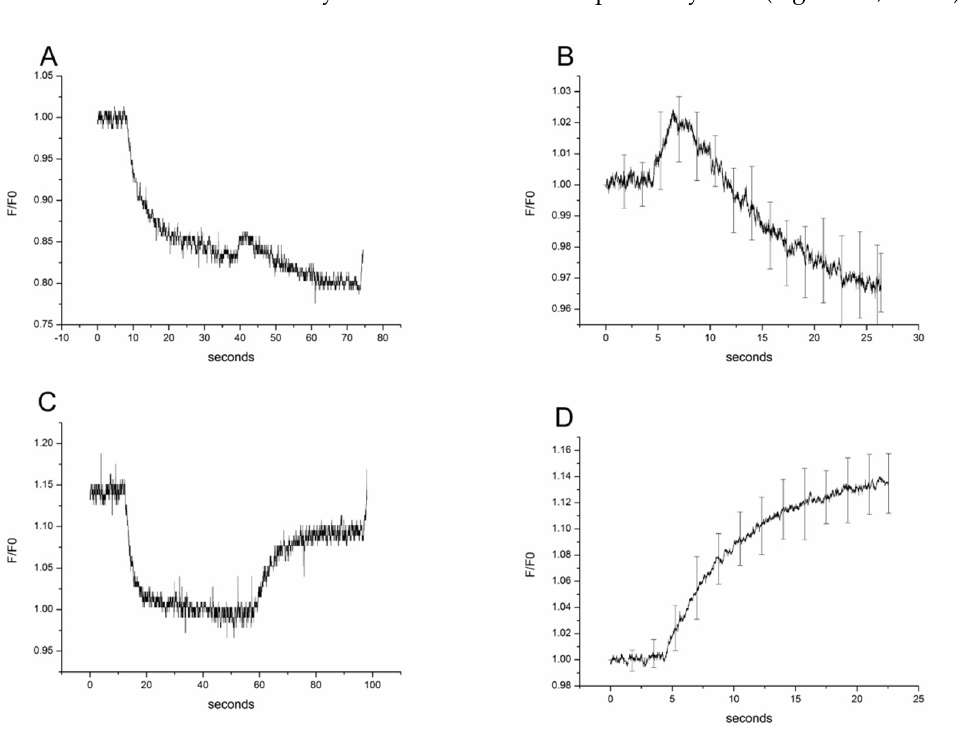
Figure 2. Effect of isotonic gradients (100 mM) of myo-inositol and urea on the cell volume of rat primary OMCD principal cells. A typical recording profile with myo-inositol incubation is given in ( A ) and the profile of the mean and SE of 18 experiments in ( B ). Typical recording profile of rat primary outer medullary collecting duct principal cells incubated with urea ( C ) and profile of mean and SD of 18 experiments ( D ). The ( B , D ) are the second part of the curves of ( A , C ) respectively, reflecting cell volume changes. They are normalized to the starting volume and the mean values of every point are used to get the mean profiles.